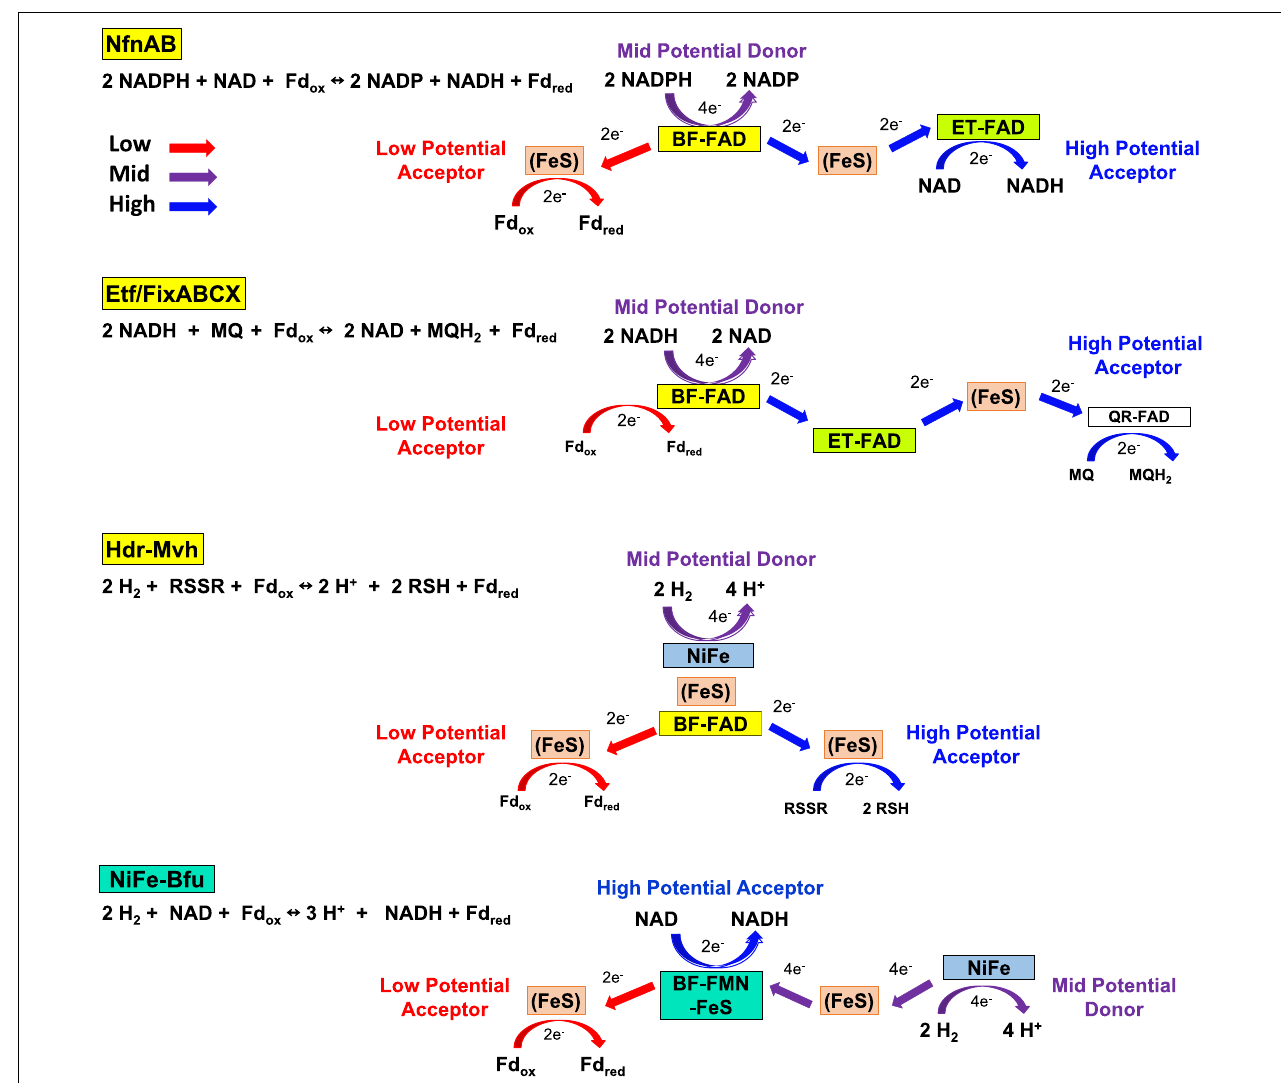
FIGURE 10 | Electron transfer pathways in the four families of electron bifurcating enzymes. The roles of flavin and the electron transfer pathways are depicted in NiFe-Bfu, NfnAB, EtfABCX, and Hdr-Mvh. For simplicity, Fd is depicted as a two-electron carrier. See text for